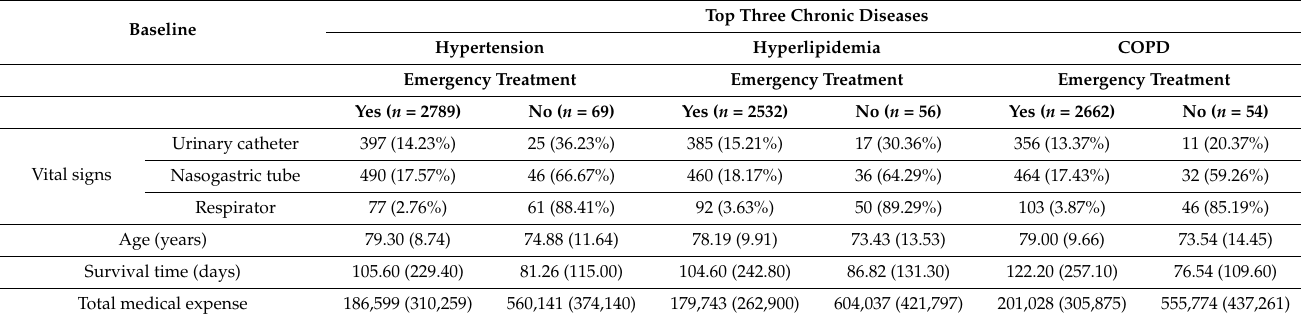
Table 4. Summary table of three chronic